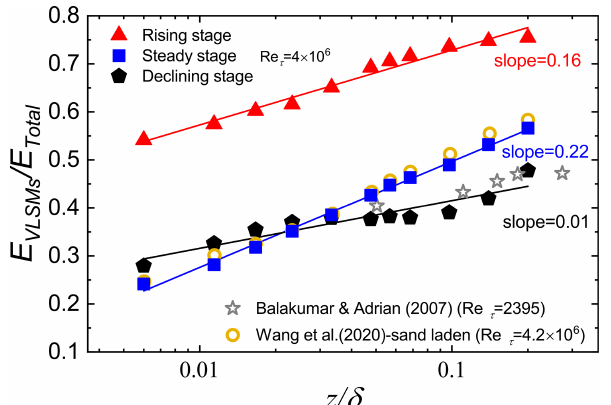
Figure 5. Variations in the energy fraction contributed by VLSMs to the total streamwise turbulent kinetic energy with height at differ- ent stages of sandstorms. The gray star is the result of Re τ = 2395 given by Balakumar and Adrian (2007), and the yellow cycle is the result of sand-laden flow at a similar Reynolds number in Wang et al.